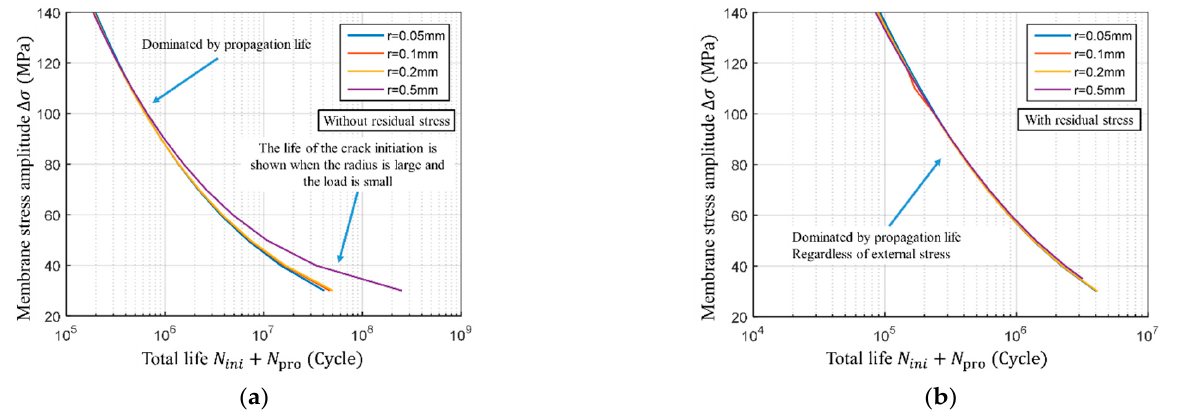
Figure 20. Calculation results of S − N curve of total fatigue life. ( a ) S − N curve of total life with different notch radius without residual stress; ( b ) S − N curve of total life with different notch radius with residual